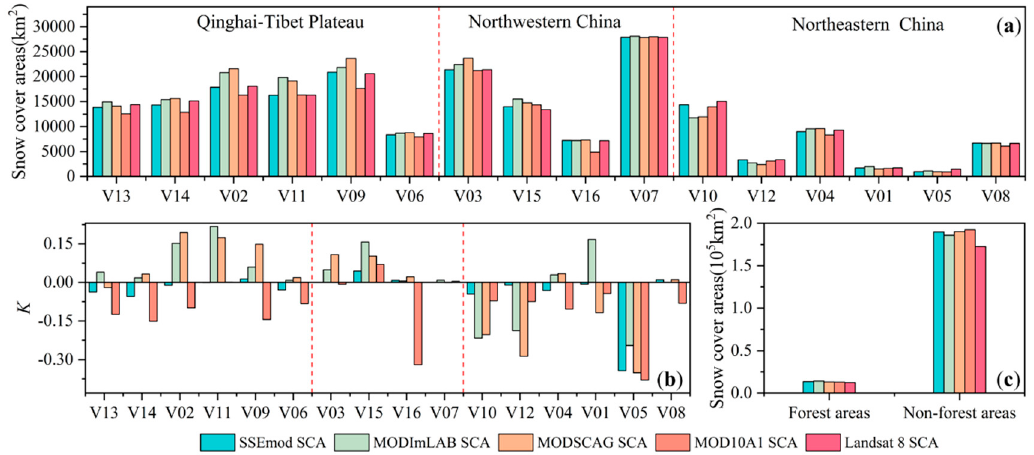
Figure 11. The validation of snow cover areas calculated by different FSC. ( a ) the validation results of the SCA estimated by FSC in different snow cover regions. ( b ) the biases factor K of different validation images. ( c ) the validation results of the SCA estimated by FSC in the forest and non-forest areas. Table 4. The average of the absolute value of K in the forest and non-forest Table 3. The average of the absolute value of K in different snow cover regions.